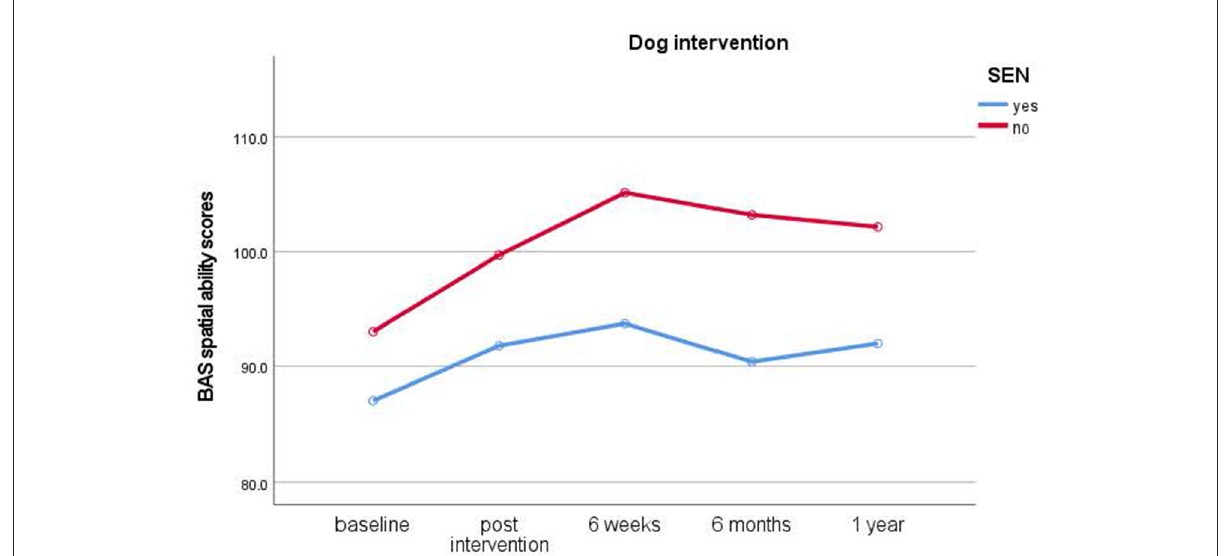
FIGURE2 Results of longitudinal assessments in the dog intervention: means for British Ability Scale spatial ability scores (y-axis) over time (x-axis) in the dog intervention group for children with and without special educational needs (SEN). Higher scores imply higher ability.